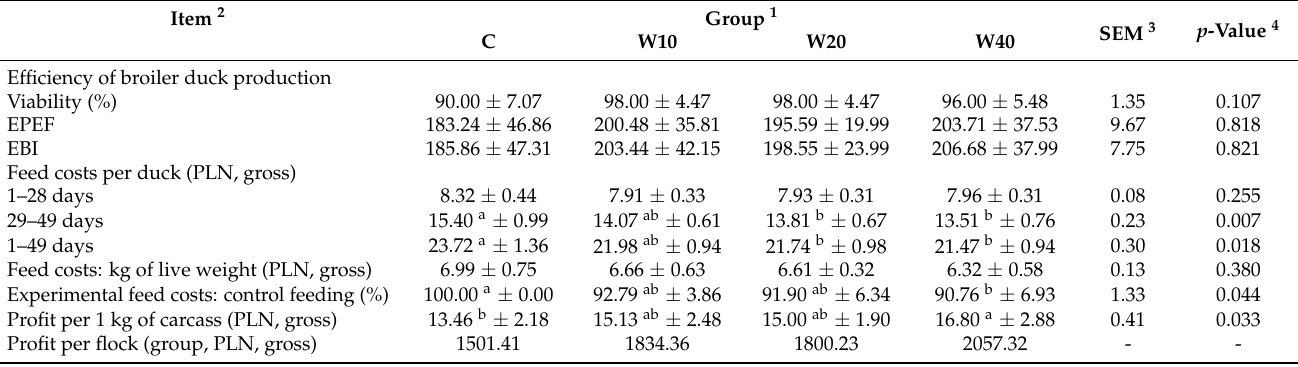
Table 3. Production efficiency of broiler ducks during 7 weeks of